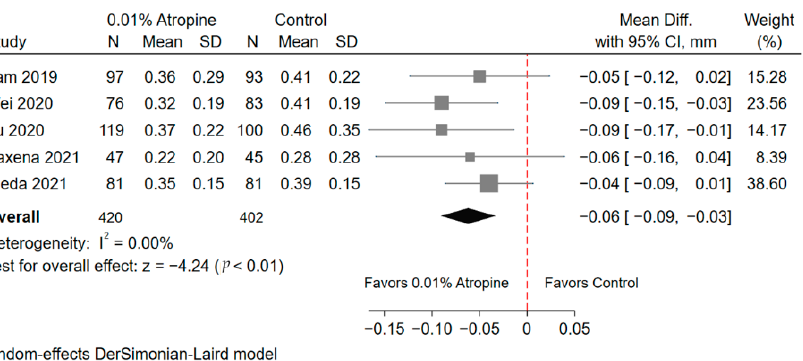
Figure 2. Forest plot of axial length between the 0.01% atropine and control groups. SD, standard deviation; CI, confidence interval.